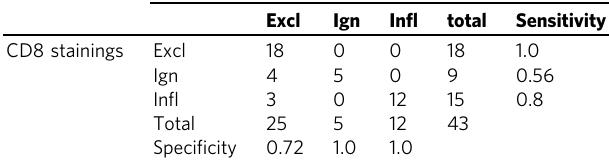
classi fi er (Supplementary Fig. 5a, b). Expression of the excluded gene-set was signi fi cantly higher in nonresponding (progressive disease (PD) patients) patients (odds-ratio (OR): 3.5; CI: 1.2 – 11.9), whereas expression of the in fl amed gene-set was signi fi cantly higher in responding patients (complete response (CR) + partial response